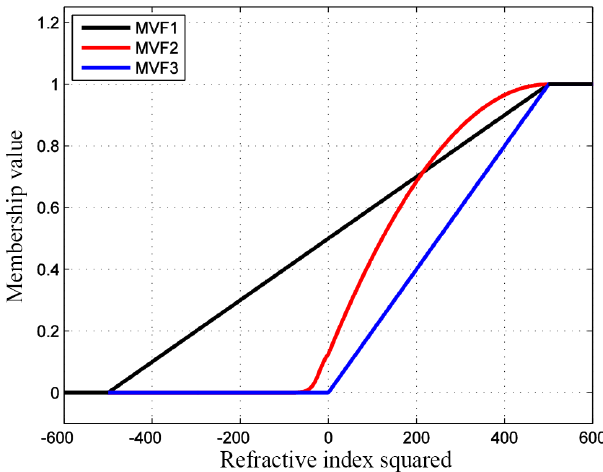
Figure A1. Shape of three MVFs that are used to calculate the val- ues of Pr Ro (y,z)